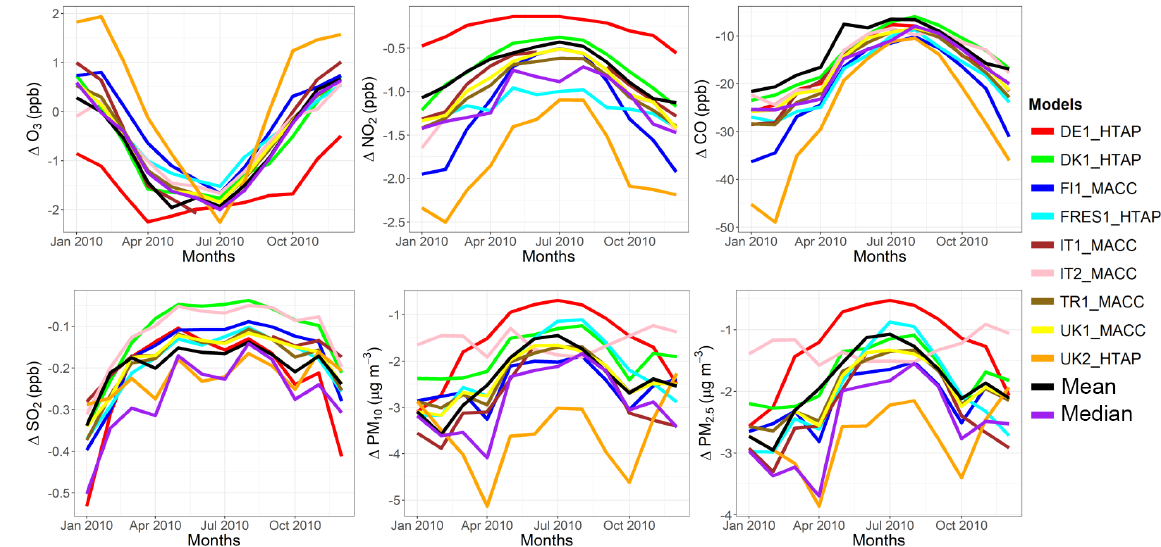
Figure 5. Absolute impact of the 20% reduction of the global anthropogenic emissions over Europe (GLO EUR − BASE EUR